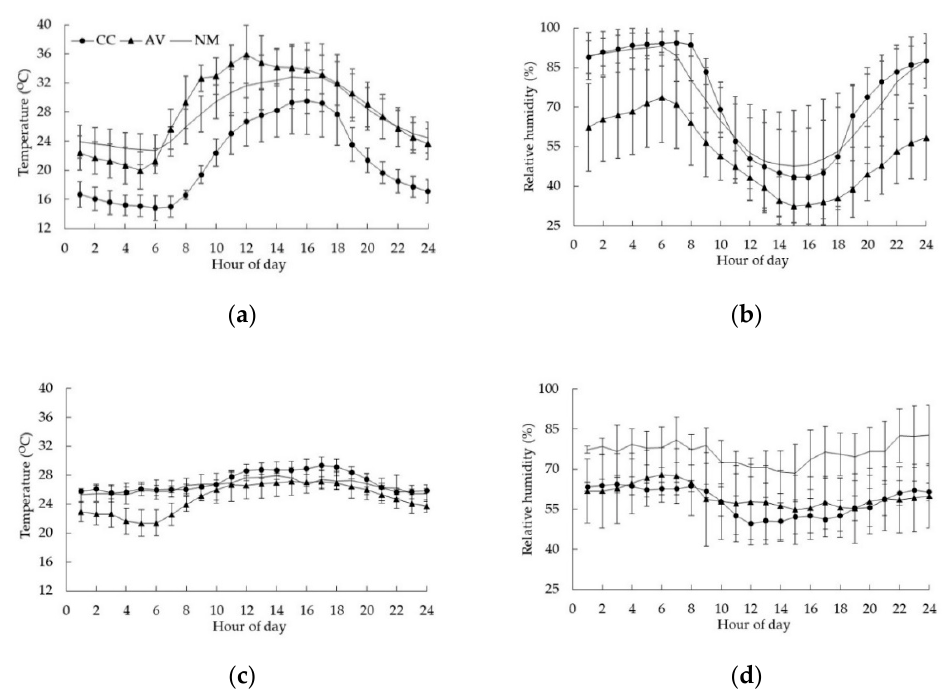
Figure 2. Outdoor and indoor diurnal temperature and RH profiles in CC, AV, and NM houses. ( a ) Outdoor temperature; ( b ) Outdoor RH; ( c ) Indoor temperature; ( d ) Indoor RH.